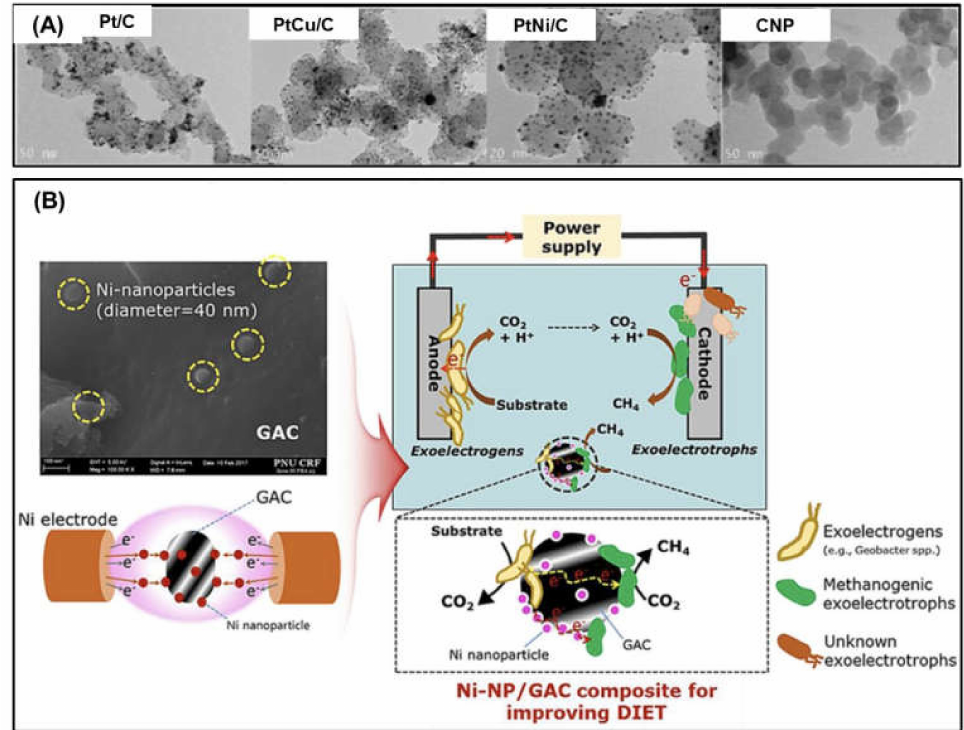
Figure 5. Metal nanoparticles used as cathode catalysts in microbial electrolysis cells: ( A ) metal nanoparticles decorated on carbon nanoparticles (CNPs). Reprinted with permission from Ref. [39]. Copyright Elsevier 2019. and ( B ) Granular activated carbon (GAC) electrodes decorated with Ni nanoparticles Reprinted with permission from Ref. [40]. Copyright Elsevier